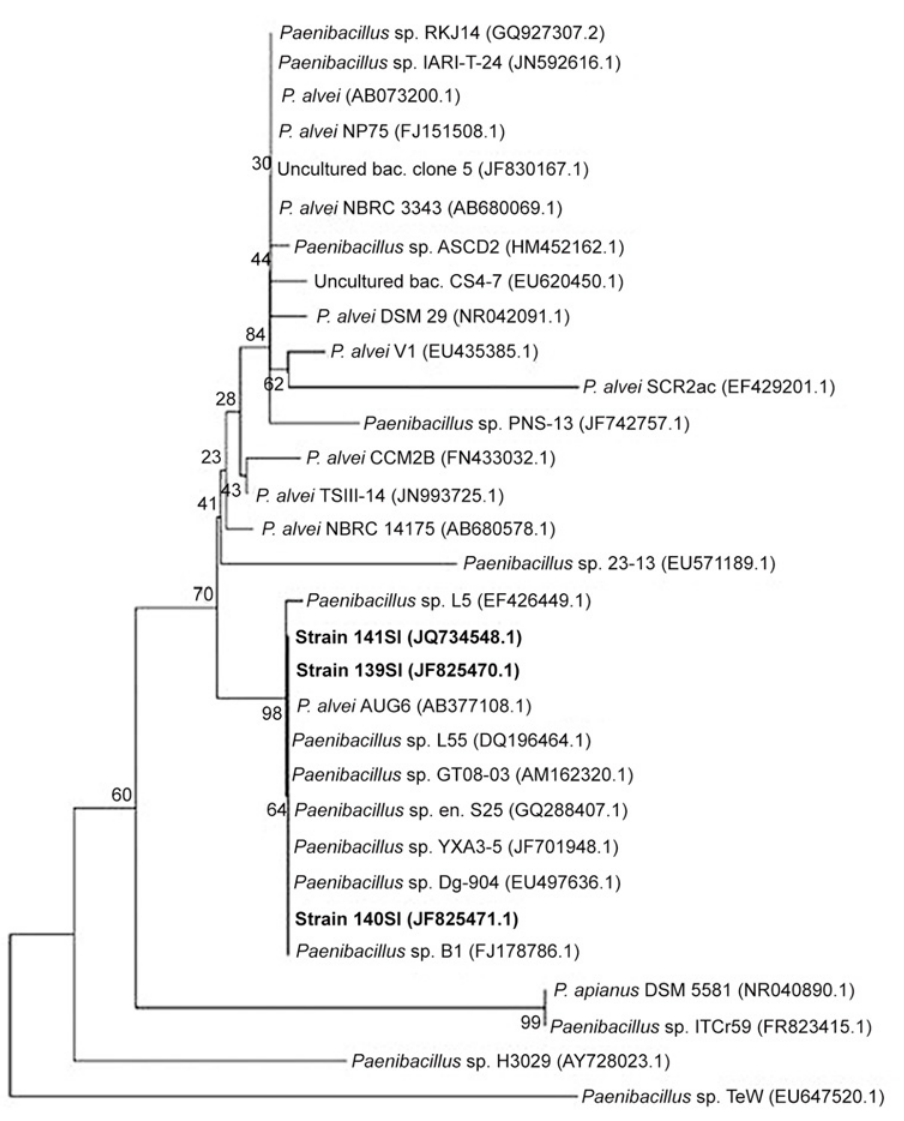
Fig 1. Phylogenetic position based on the 16S rRNA gene sequences. The neighbor-joining method was performed, followed by 1000 replications of bootstrapping.